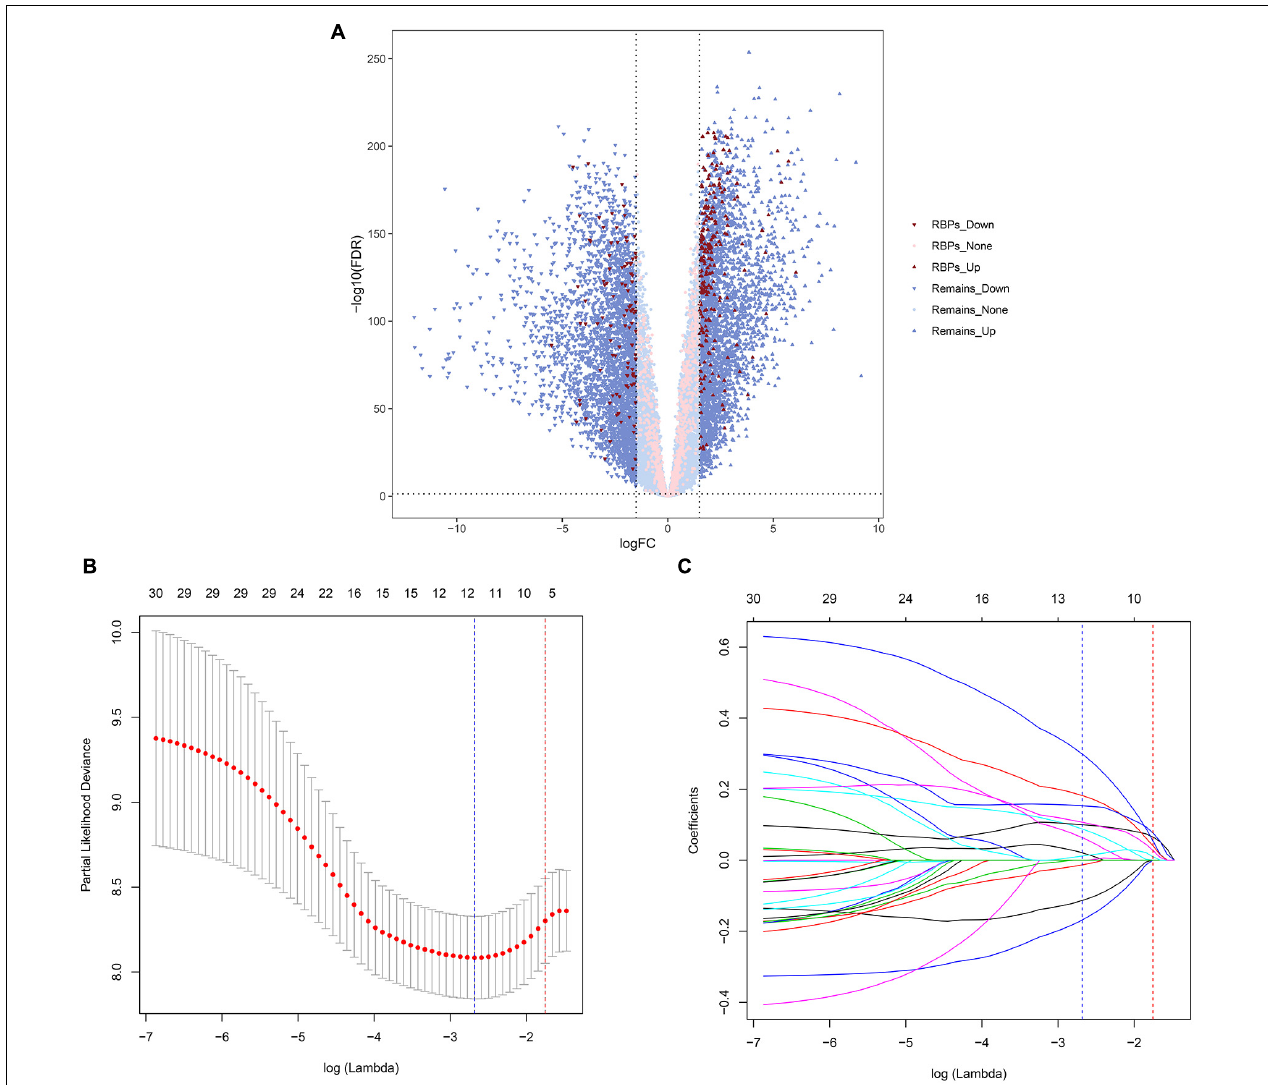
FIGURE 1 | Volcano map and least absolute shrinkage and selection operator (LASSO) regression analysis of The Cancer Genome Atlas (TCGA) cohort. The volcano map shows the differential expression of genes. The up and down arrows represent upregulated and downregulated genes, respectively; red and pink represent genes with and without differential expression of RNA-binding protein (RBP)-encoding genes, respectively (A) . The selection of LASSO regression truncation value after cross-validation, and the blue dotted line represents the lambda corresponding to the lowest error mean. The red dotted line represents the maximum lambda corresponding to the error mean within one standard deviation of the minimum (B) . Prognosis-related gene selection in the LASSO–Cox regression (C)